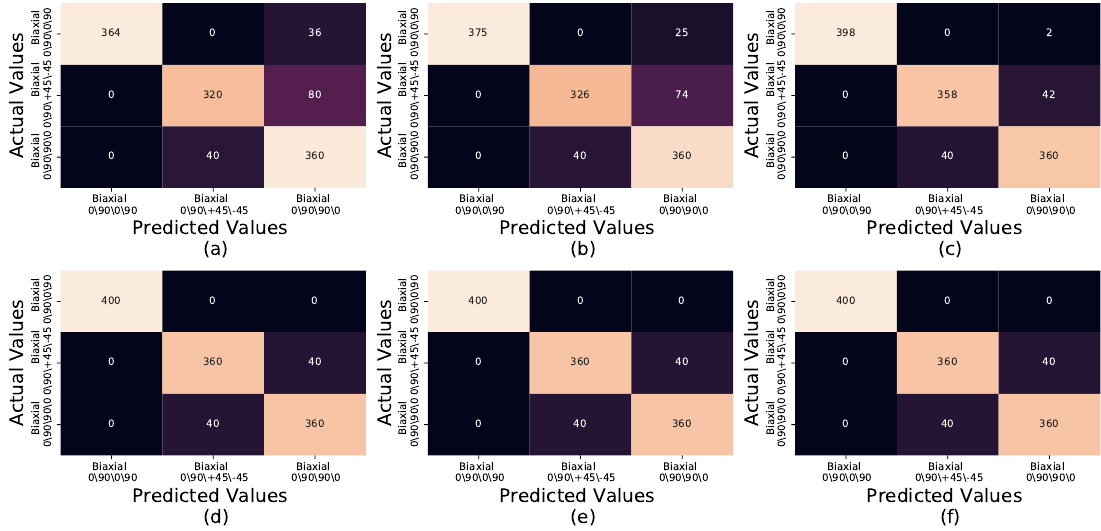
Figure 7. Confusion matrices of Biaxial 0/90/0/90, Biaxial 0/90/+45/ − 45 and Biaxial 0/90/90/0, for bandwidths: ( a ) 0.6 ( b ) 0.5 ( c ) 0.4 ( d ) 0.3 ( e ) 0.2 ( f ) 0.1. Table 3. Classification report for synthetic samples, bandwidths 0.6 through to